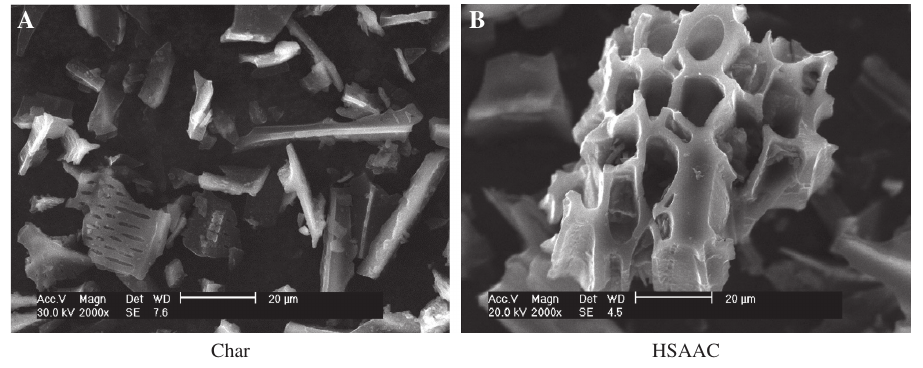
Figure 8: Scanning electron microscopy (SEM) image of char and high surface area activated carbon